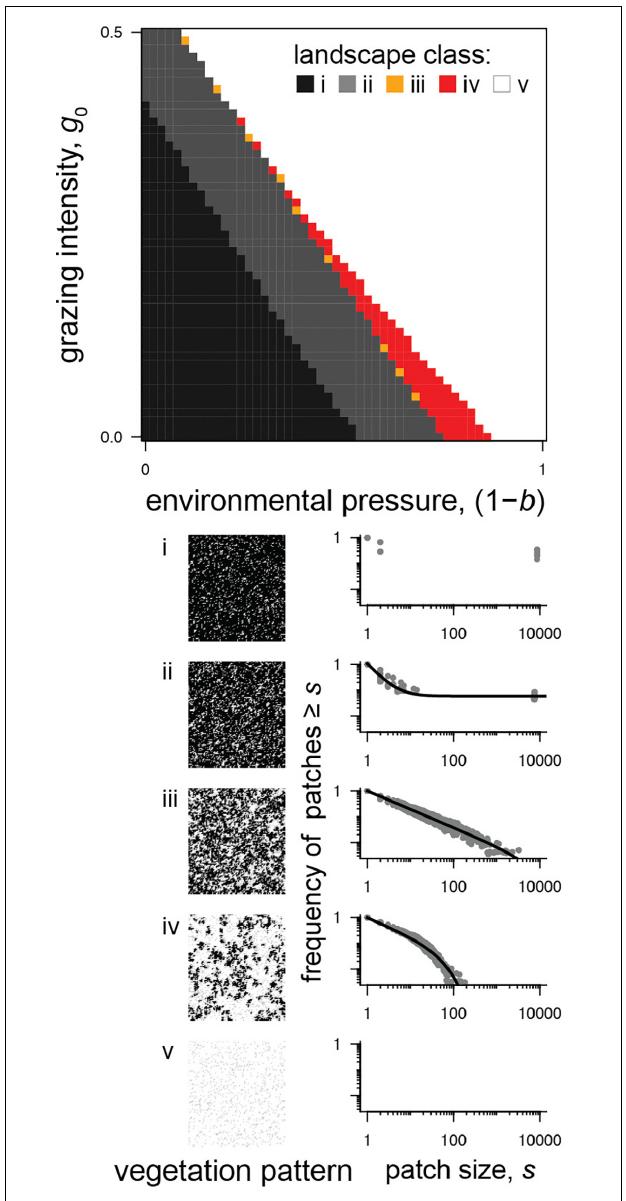
FIGURE 6 | Model results of dryland grazing model by Schneider and Kéfi (2016). Model landscapes were classified based on the shape of the inverse cumulative patch–size distributions obtained from repeated simulation runs along gradients of environmental and grazing pressures. If crossing the tipping point, the system transitions from vegetated (i.e., shaded area) to desert (white area). Classes are i: full cover; ii: up-bent power-law with spanning clusters; iii: straight power-law; iv: down-bent power law (the early-warning-sign of a catastrophic shift); v: desert. Note that at high grazing pressure, a vegetation collapse was not preceded by down-bent power laws